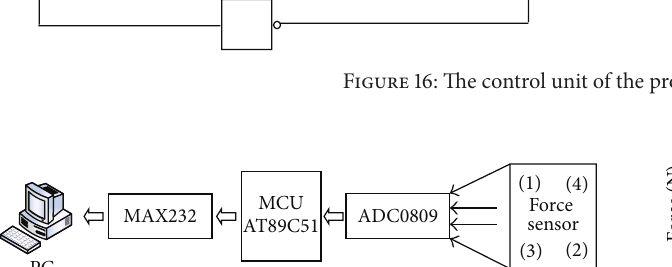
one-third of the system weight in the supporting phase. The time sequence of each leg force indicates that the walking paces are in a well-coordinated manner. This is ensured by the solid mechanical linkages between each leg and